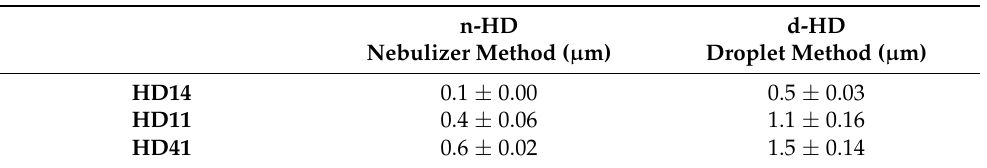
Table 1. Thickness of the hydrogel coatings generated by the nebulizer (n-HD) and droplet method (d-HD), respectively. ( n =